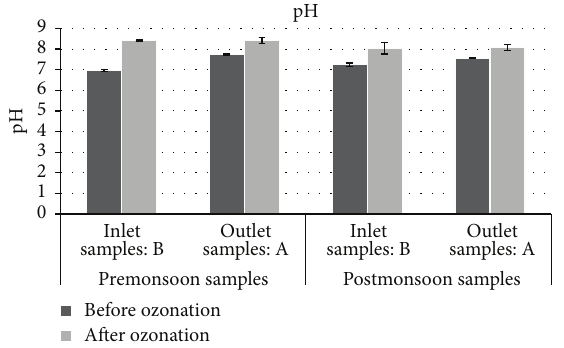
Figure 7: Total dissolved solids of inlet and outlet samples before and after treatment by